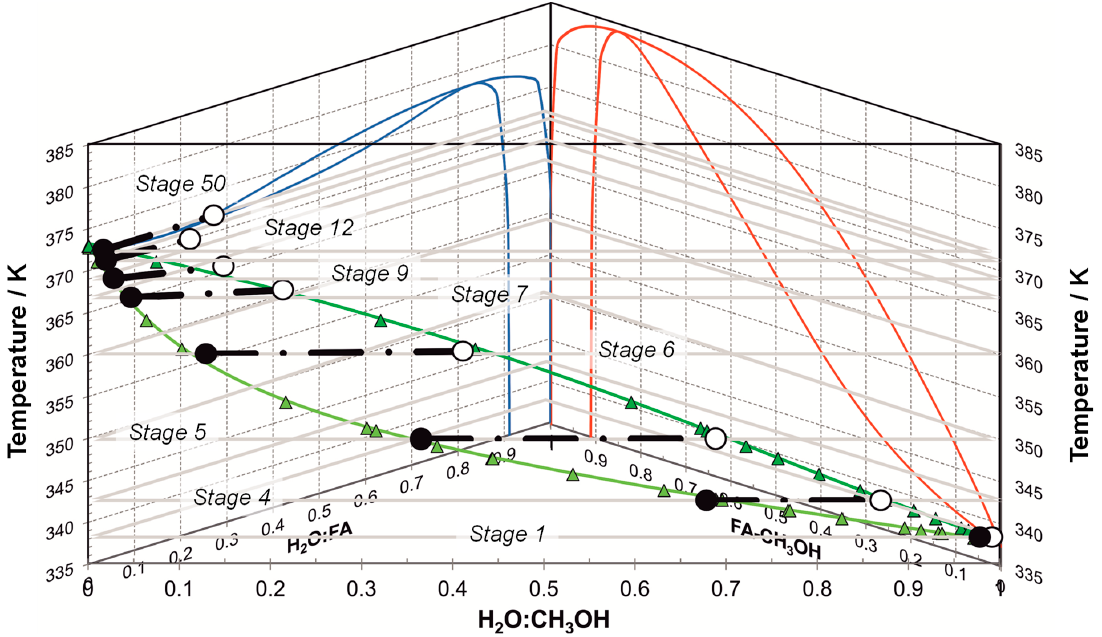
Figure 11. Illustration of the phase equilibria W/MeOH/FA with experimental literature data [80] and conodes of selected stages in column C-2; see Figure 10.